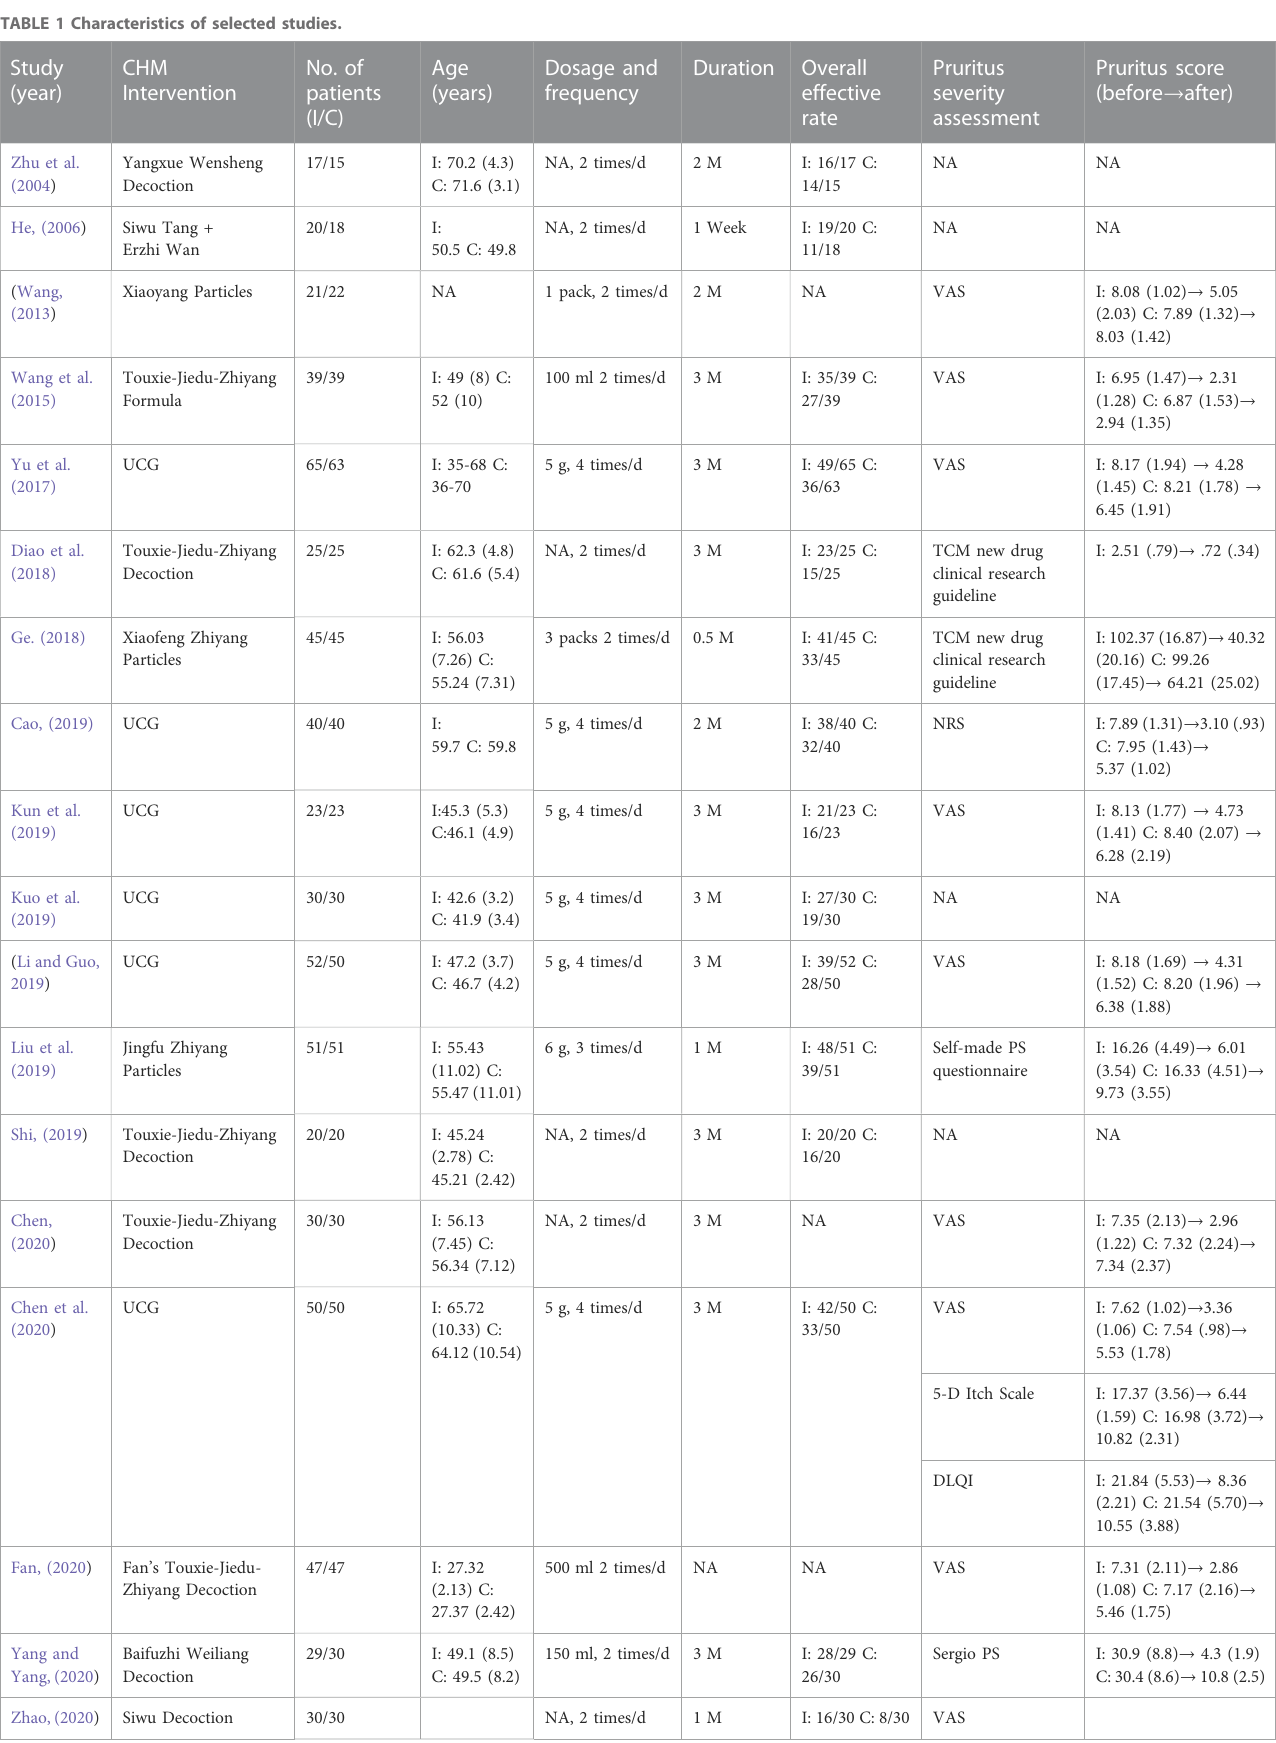
TABLE 1 Characteristics of selected studies.